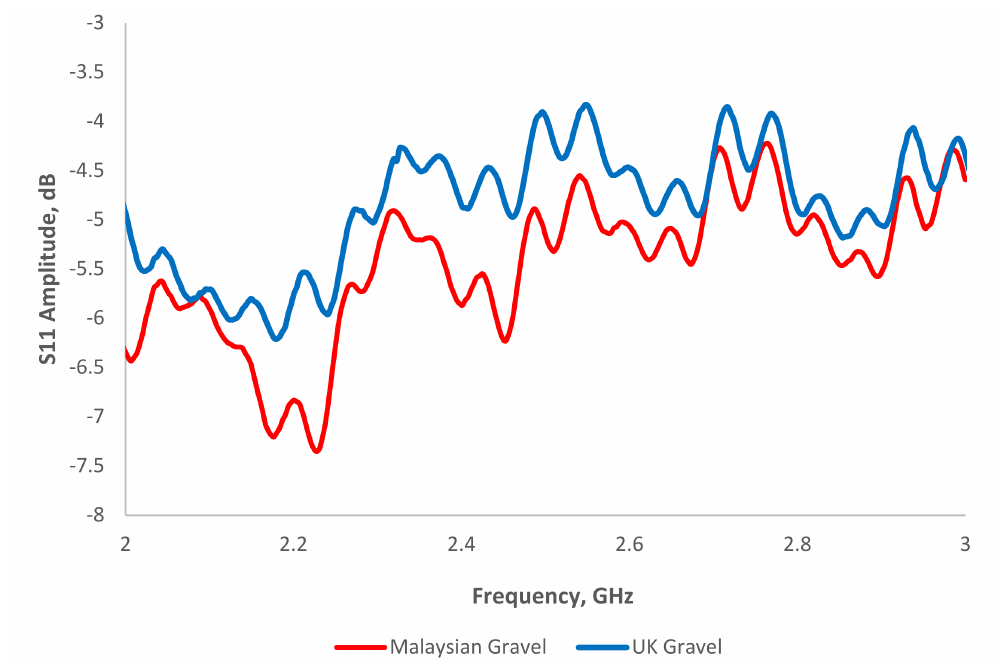
Figure 12. Signal spectrum for MS 26-MS 26-1-8:2010 concrete and Europe EN 206-1-2013 concrete in